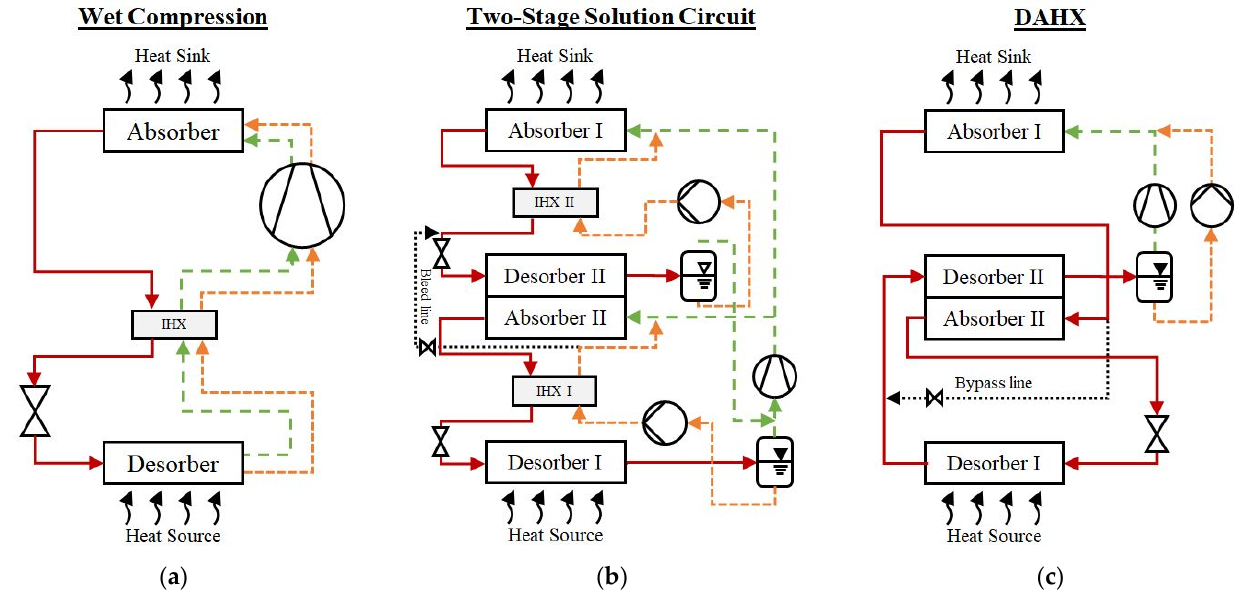
Figure 2. Schematic representations of ( a ) a wet compression cycle, ( b ) ACHP with two-stage solution circuit and ( c ) ACHP with single circuit and desorber/absorber heat exchange (DAHX).